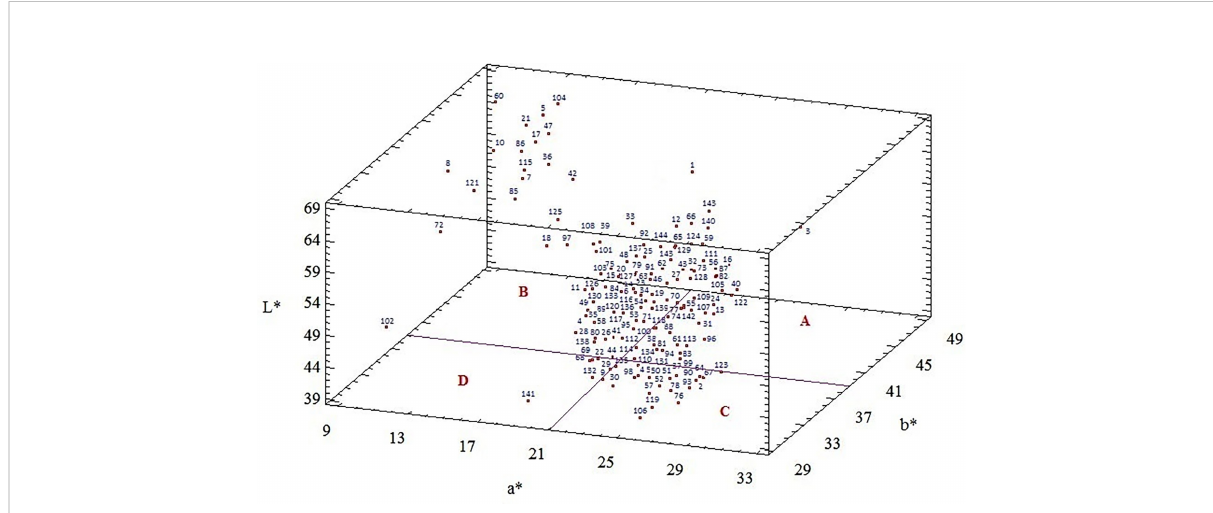
FIGURE 1 CIE L*, a*, b* color diagram for seeds of 144 fl ax genotypes. Part (A) consisted of genotypes with intermediate to high values of color parameters a*, b*, and L*. Part (B) included genotypes with low to medium values of a* parameter and intermediate to high values of b* and L* parameters. Part (C) contained genotypes with intermediate to high values of a* and low to medium values of the b* and L*. Part (D) included genotypes with low to medium values of a*, b*, and L*